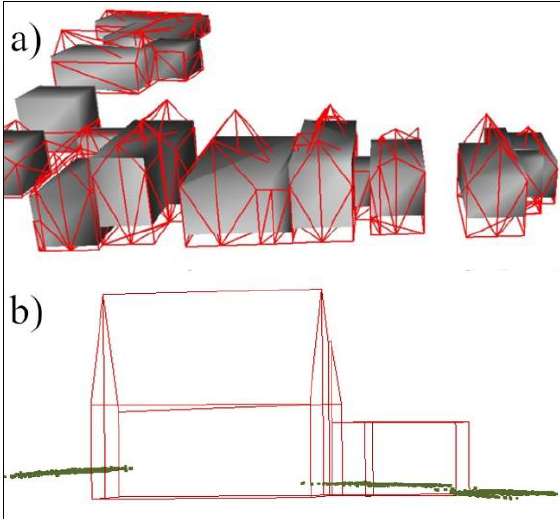
Figure 13. [a] Example of misalignment between footprint heights in the nDSM buildings (as grey boxes) and the LoD22 buildings (in red wireframe). [b] Example of a building surrounded by terrain points at different